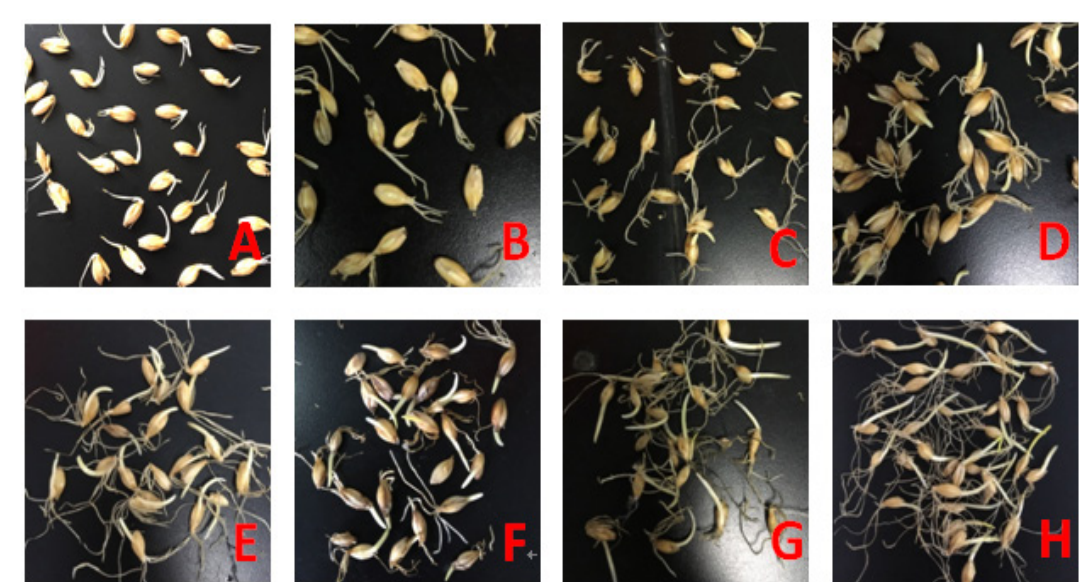
FIGURE 1 – Different bud of F. H. Germinatus. (A) 0.25 cm; (B) 0.50 cm; (C) 0.75 cm; (D) 1.00 cm; (E) 1.25 cm; (F) 1.50 cm; (G) 1.75 cm; (H) 2.00 cm.